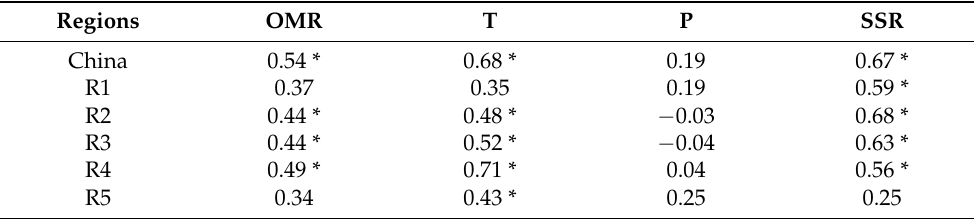
Table 2. Correlation coefficients between NDVI and OMR and meteorological elements.